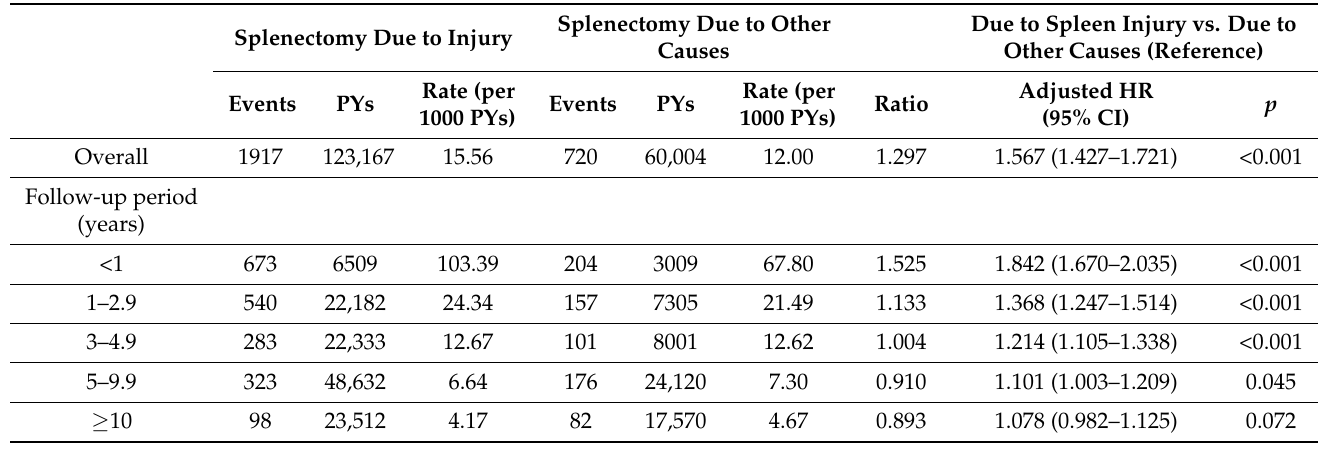
Table 3. Risk factors for pneumonia according to spleen injury status and the duration of follow-up, and the effect of spleen injury on the risk of